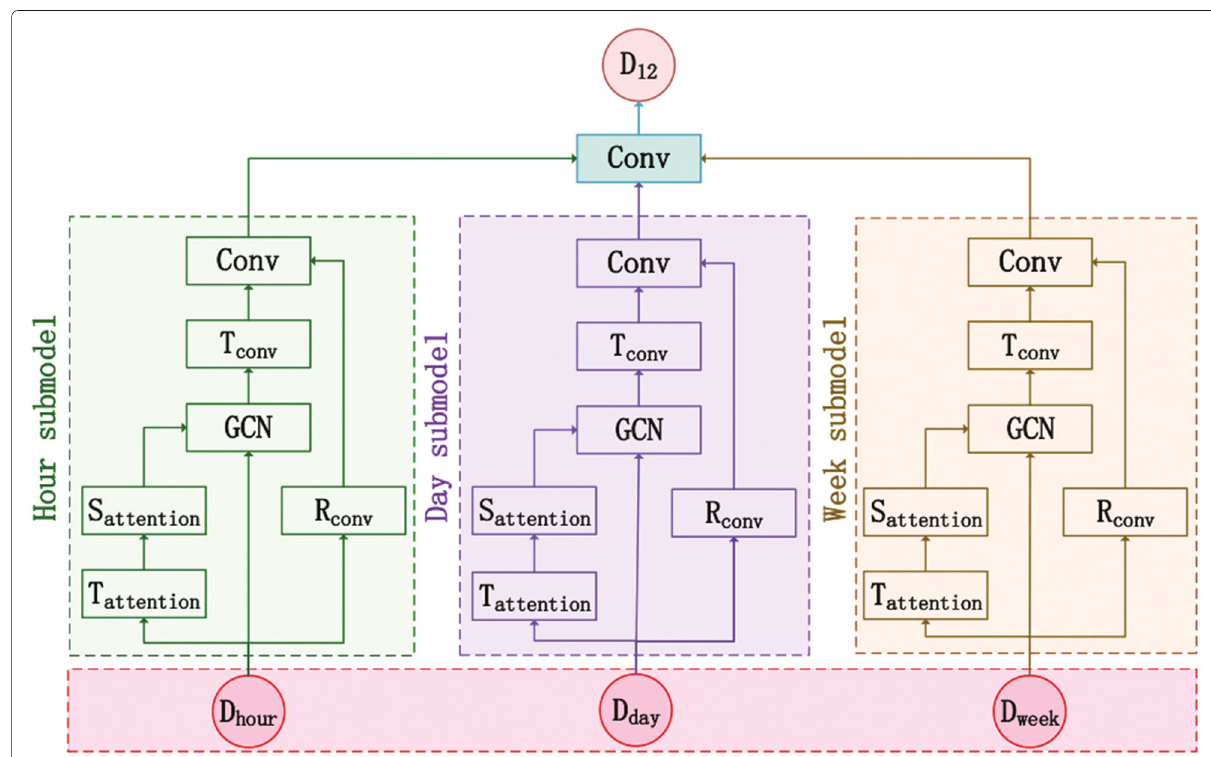
Fig. 2 The framework of ASTGCN . D hour : Recent training data; D day : Daily-periodic training data; D week : Weekly-periodic training data; D 12 : The forecasted values of the next 12 time slots; T attention : Temporal Attention; S attention : Spatial Attention; GCN : G raph C onvolution N etwork; T conv : Temporal Convolution; R conv : Residual Convolution; Conv : Common Standard